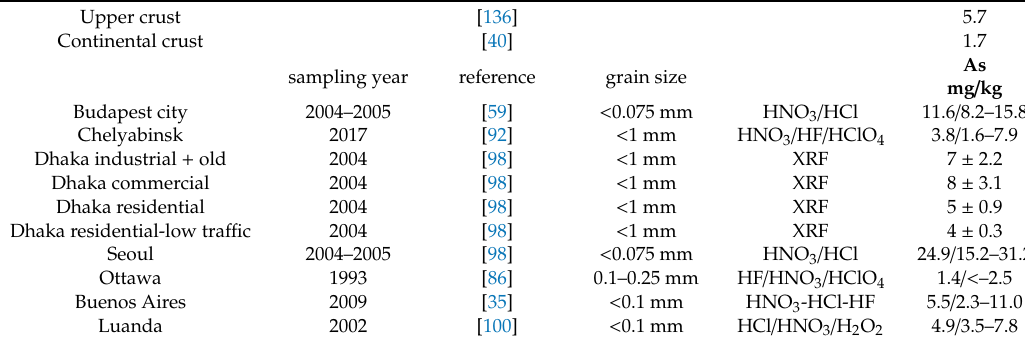
Table A23. Arsenic in road dust.